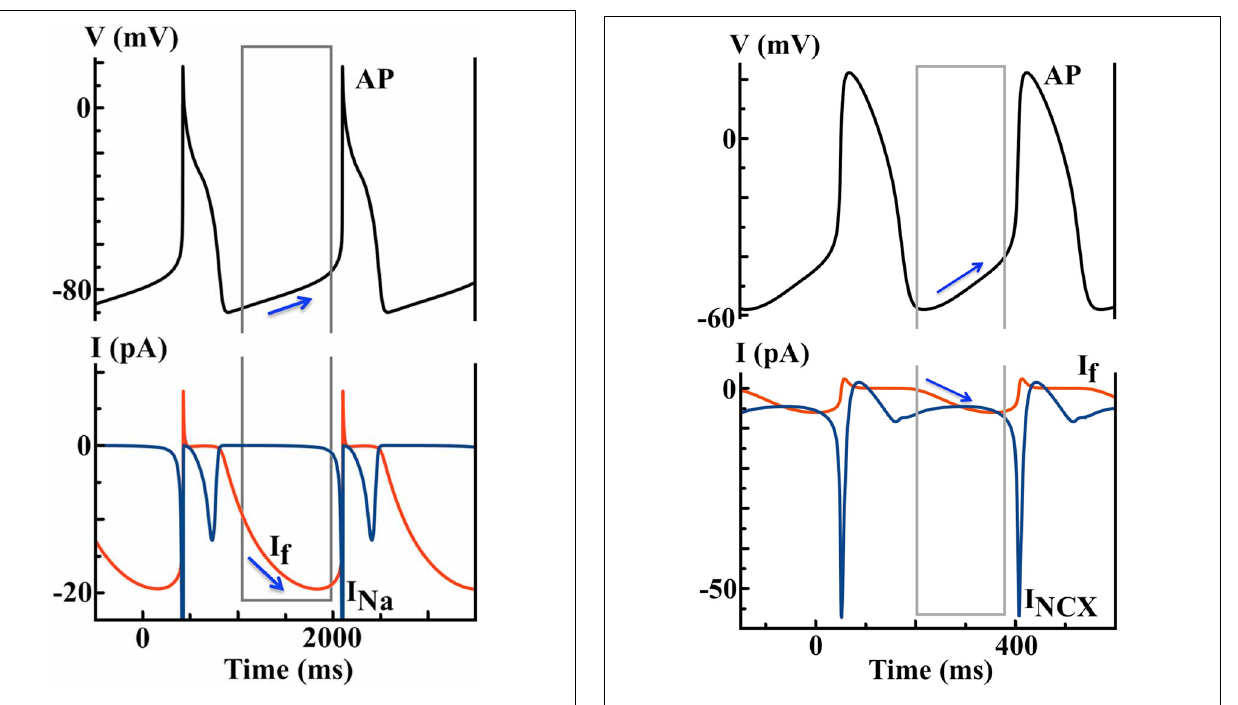
FIGURE 4 | Simulated AP and ionic currents using the SD SAN model to illustrate the I f hypothesis. Blue arrows indicate the changes of I f during the DD finally triggers a spontaneous AP, while the contribution of I NCX is less